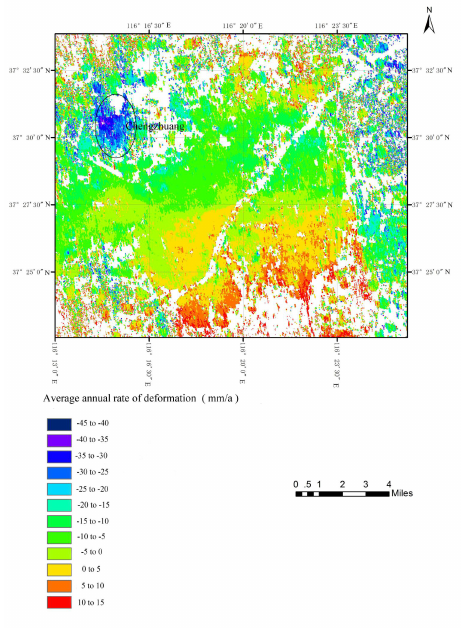
Figure 4. Annual average rate of deformation in urban areas of